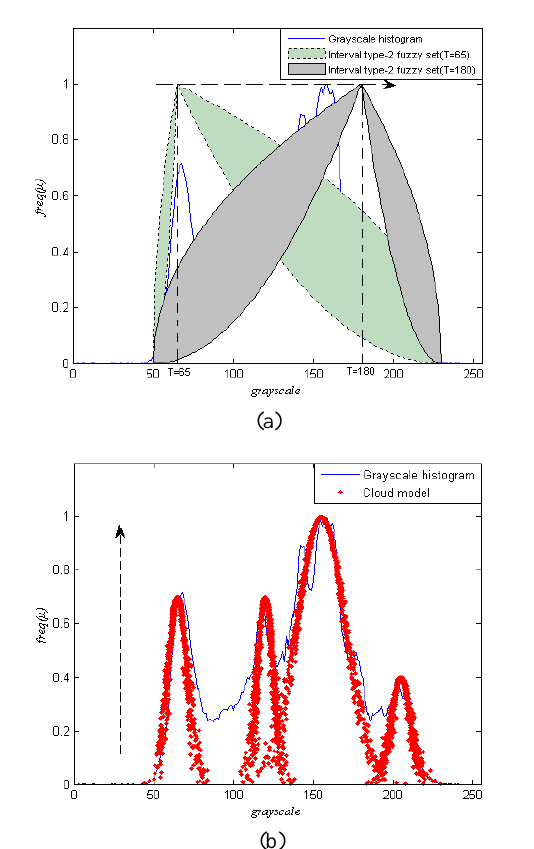
Fig. 3. Comparison on the histogram analysis: (a) ITT2; (b)